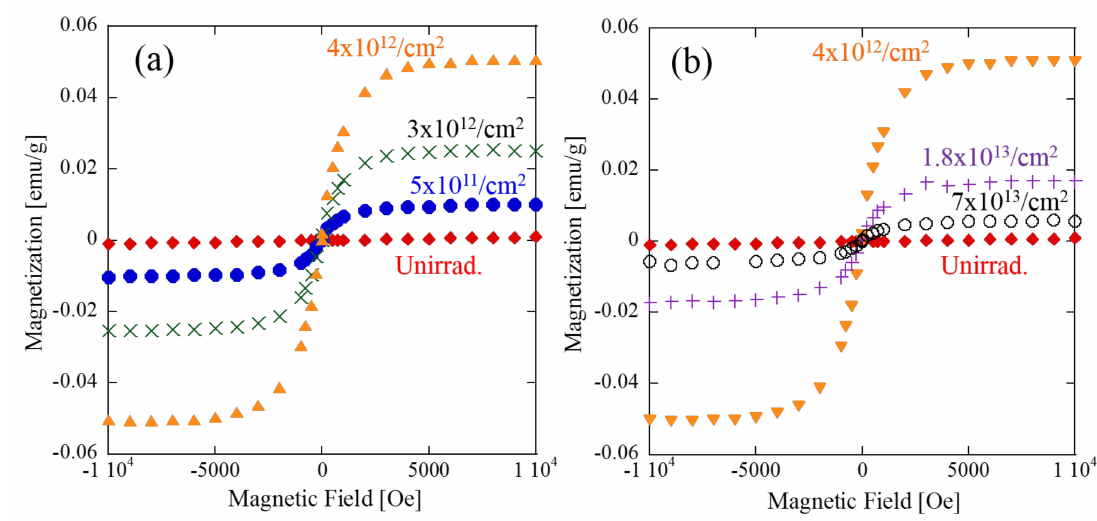
Figure 4. Magnetization-magnetic field (M-H) curves of CeO 2 for various Xe ion fluences, ( a ) for lower fluences, the magnetization increases with increasing ion fluence, and, ( b ) for higher fluences, the magnetization decreases with increasing ion